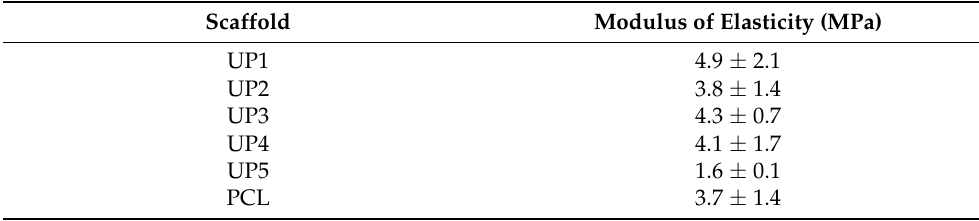
Table 2. Compressive modulus of elasticity of PCL and UP scaffolds ( n =